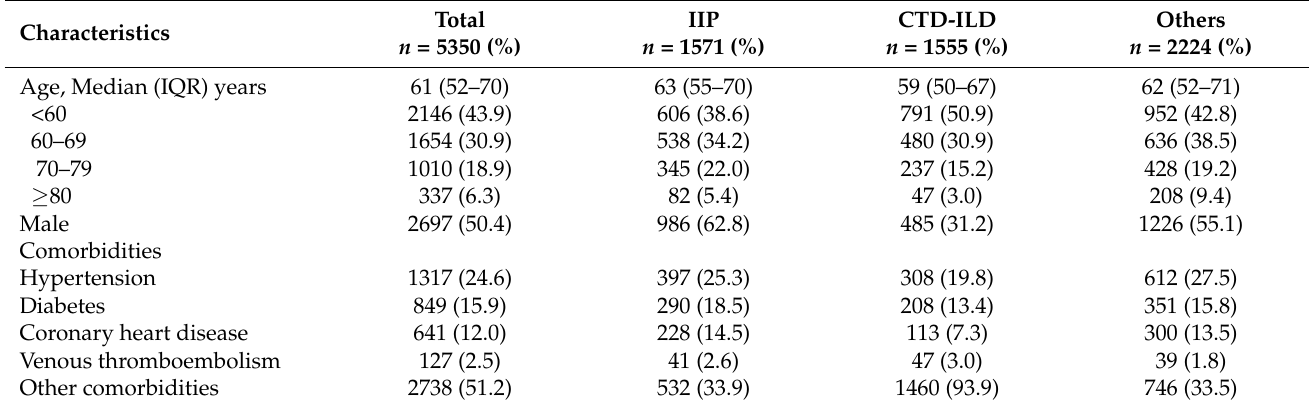
Table 1. Total demographic characteristics of patients with IIP, CTD-ILD, and other ILDs.